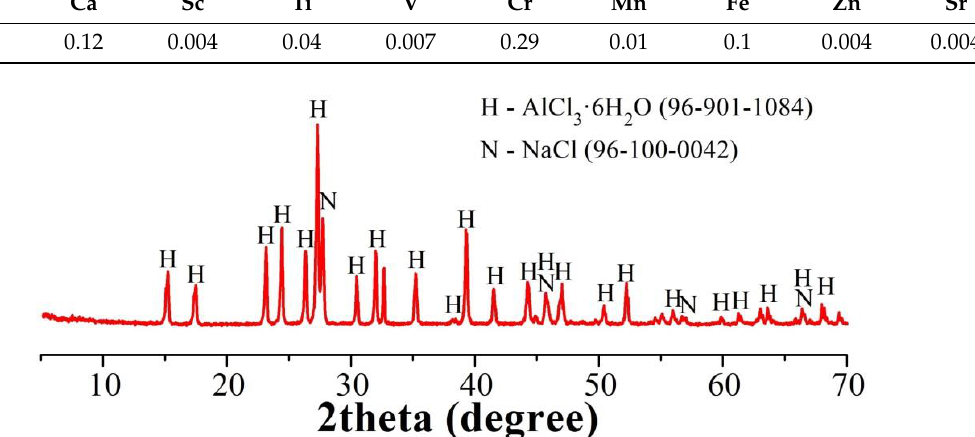
Figure 6. The XRD pattern of ACH precipitated from the mother liquor by its saturation using gaseous HCl.